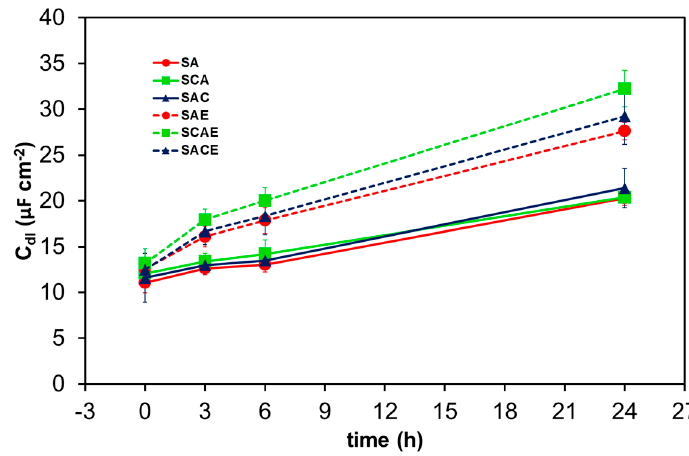
Figure 9. Average double layer capacitance ( C dl ) of the different AA6012 samples in aerated solution as a function of exposure time.